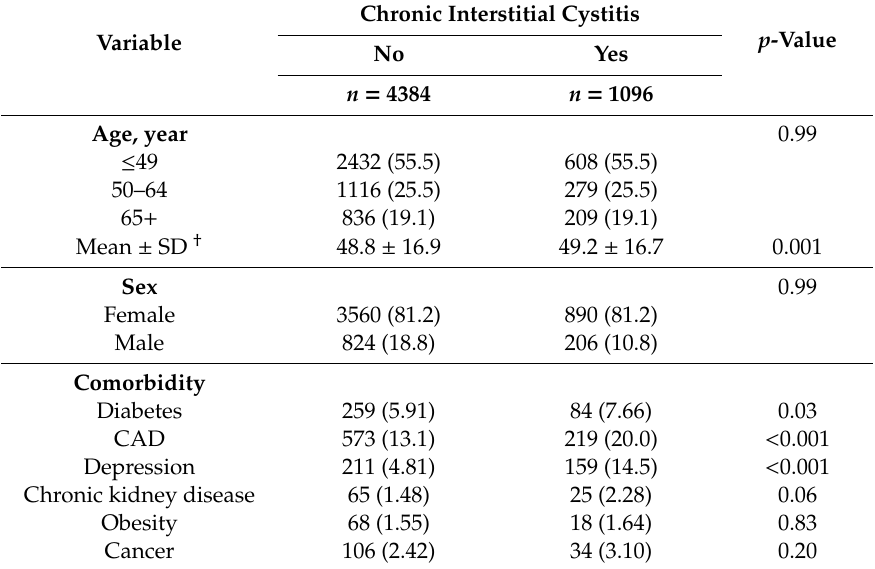
Table 1. Demographic characteristics and comorbidities in cohorts with and without chronic interstitial cystitis.